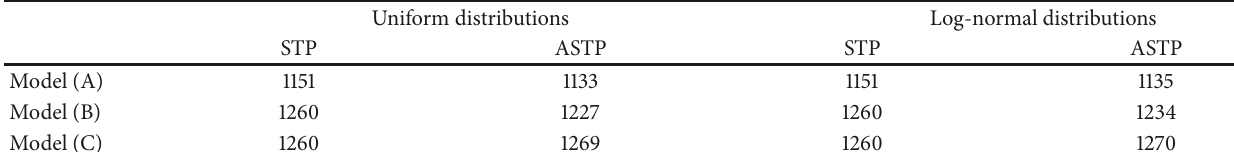
Table 6: The results of the optimized timetables.